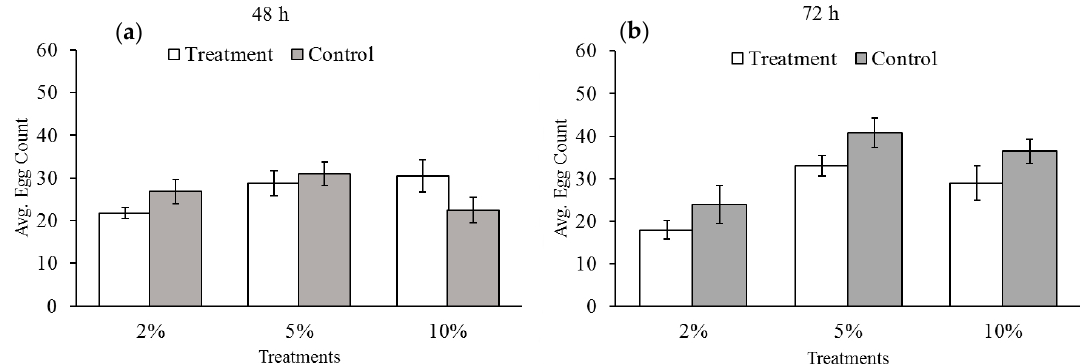
Figure 1. Mean number of eggs laid by female cowpea bruchids during ( a ) 48 and ( b ) 72 h of exposure to hypoxia. Asterisks represent statistically significant differences between oxygen treatment groups (white) and paired control groups (gray). Bars with no asterisk were not significantly different from the control group. Oxygen levels had no effect on the number of eggs laid relative to the control groups with the exception of the 10% treatment group exposed for 48 h.